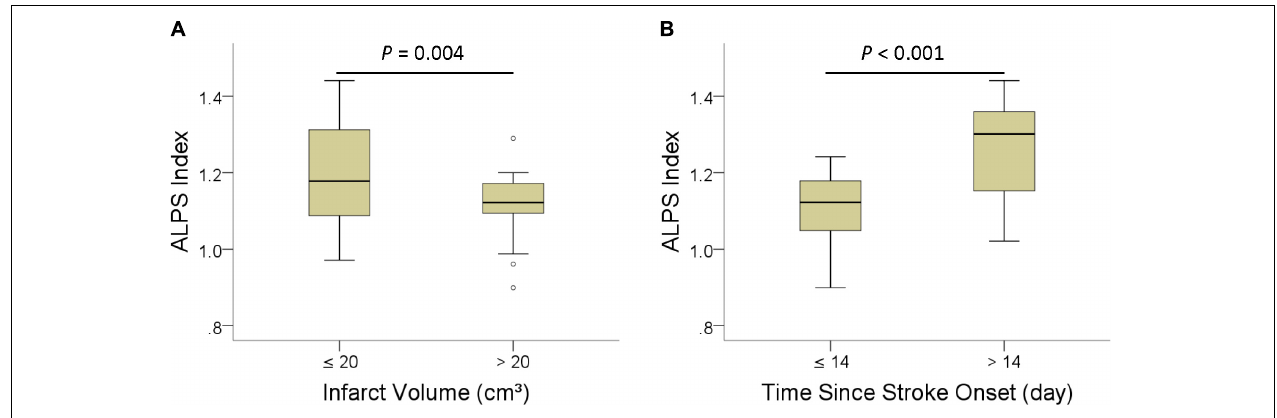
FIGURE 4 | Boxplots of ALPS index with regard to infarct volume (A) , and (B) time since stroke onset.